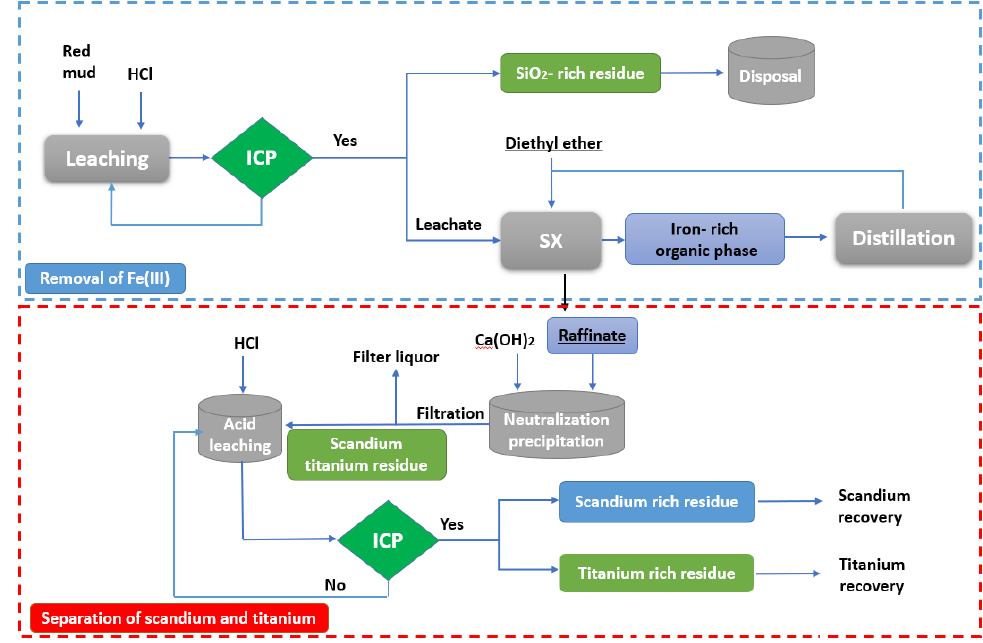
Figure 21. The proposed flow-chart of scandium separation from Guangxi Pinglu RM, adapted from [155].